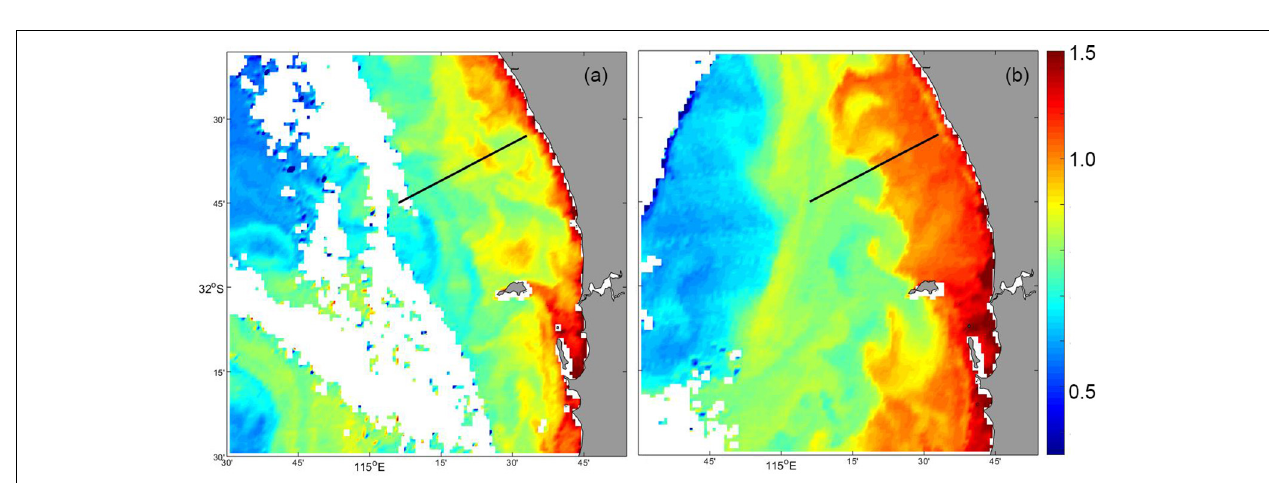
FIGURE 9 | MODIS satellite derived surface chlorophyll concentration: (a) 18 May 2009; and (b) 29 May 2009. The glider transect is shown as the dotted line.